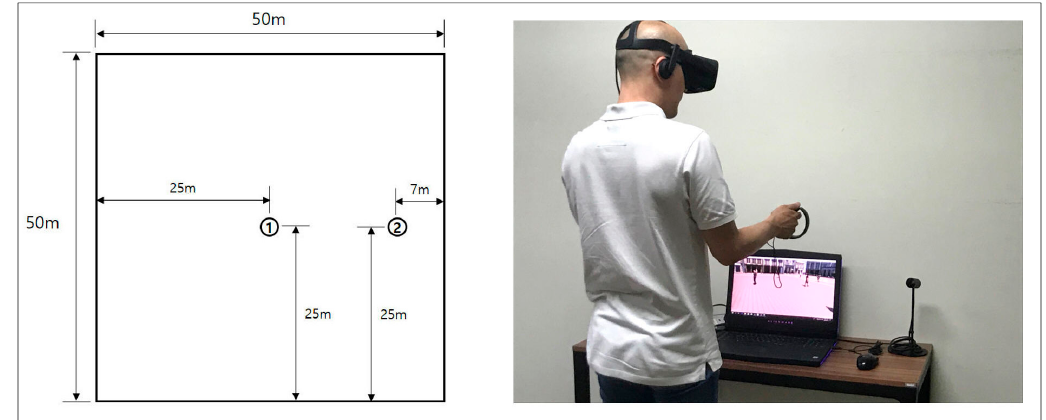
Figure 2. Observation points (center 1 (cid:13) and side 2 (cid:13) ) ( Left ) and actual VR experiment scene ( Right).